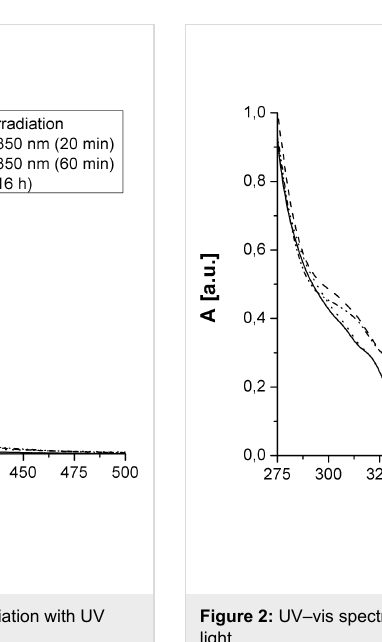
NMR- and MALDI-TOF-measurements were of no assistance in establishing the identity of the photoproducts from 5a and 5b after UV irradiation. 1 H NMR-spectra of the irradiation products (after evaporation of solvent) indicate that there is more than one reaction pathway, the number and overlapping of